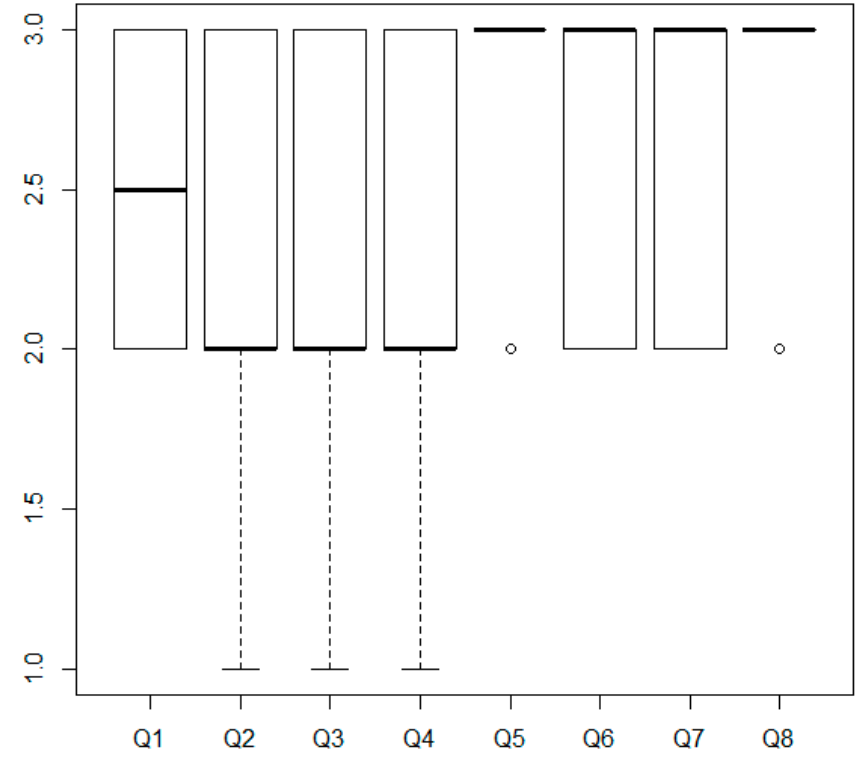
Figure 2. Lecture: Distribution of responses.